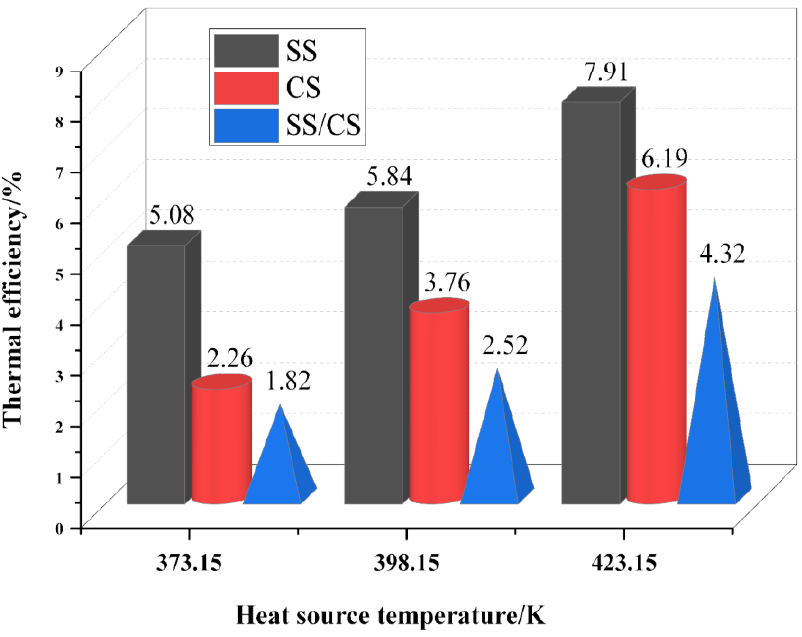
Figure 12. Thermal efficiency of the systems under optimal operating conditions.